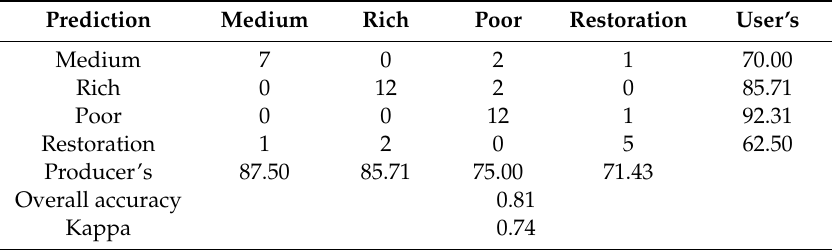
Table A6. Confusion matrix of classification in